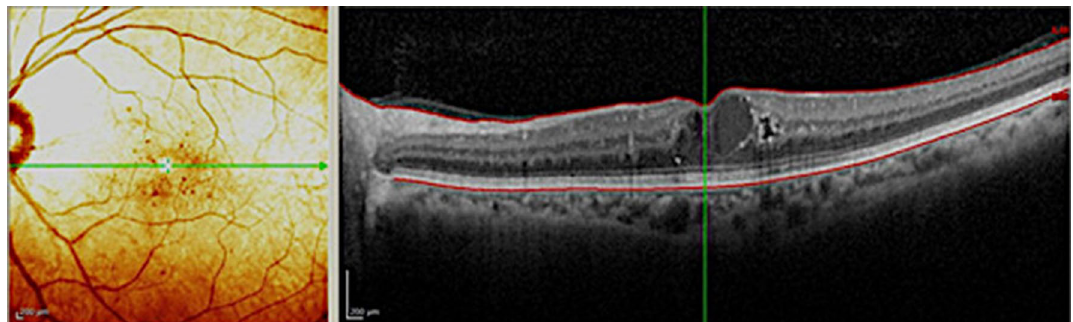
Figure 2. A pre-treatment spectral-domain optical coherence tomography scan of an eye with non-proliferative diabetic retinopathy and diabetic macular edema with increased foveal thickness.